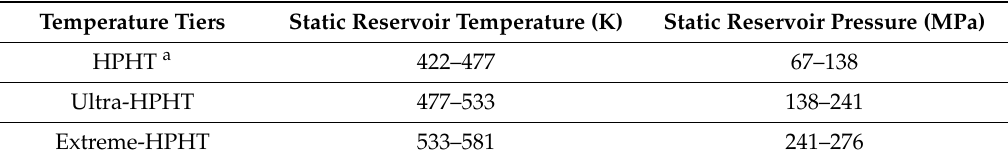
Table 1. Oil and gas well high temperature high pressure tiers